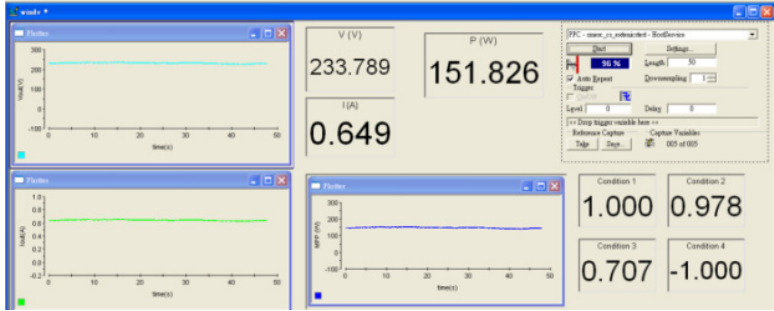
Figure 22. The real-time status diagnosis dSPACE software